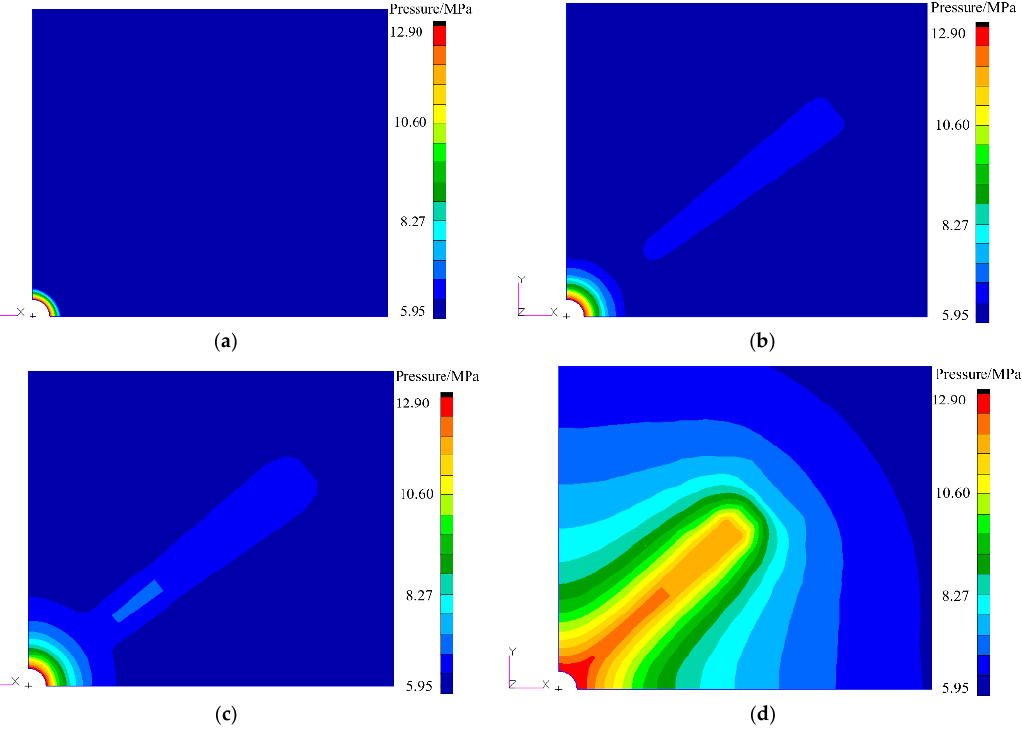
Figure 5. ( a – d ) Pressure propagation during water injection in the model when the fracture does not intersect the wellbore (top view), MPa.